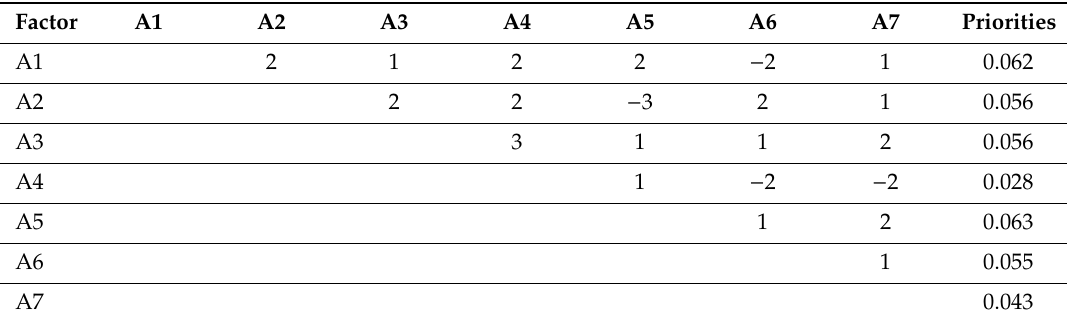
Table 5. Compare the relative importance with respect to financial criterion (A).